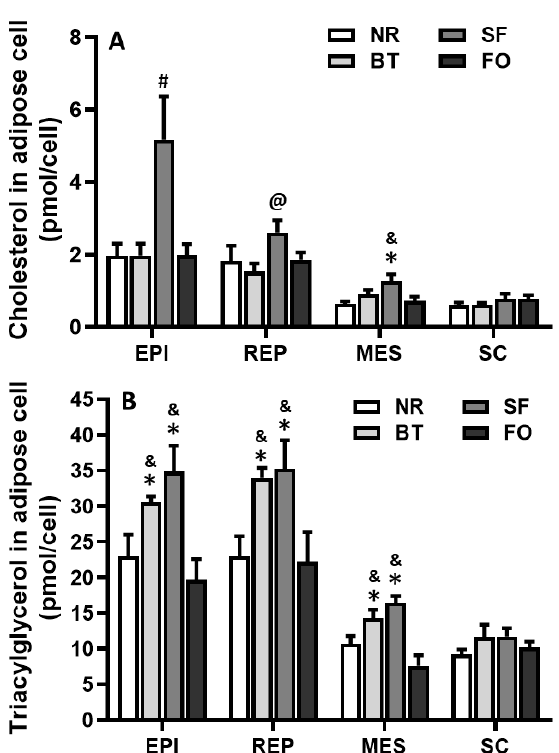
Figure 7. Comparison of cholesterol ( A ) and triacylglycerol ( B ) contents in the adipose cells of epididymal (EPI), retroperitoneal (REP), mesenteric (MES) and subcutaneous (SC) fat pad in rats after different diet feeding for 4 weeks. Values are expressed as mean ± SE.; n = 6, # p < 0.05, vs. the rest 3 groups; @ p < 0.05, vs. beef tallow (BT); * p < 0.05, vs. normal rodent diet (NC); and & p < 0.05, vs. fish oil (FO).